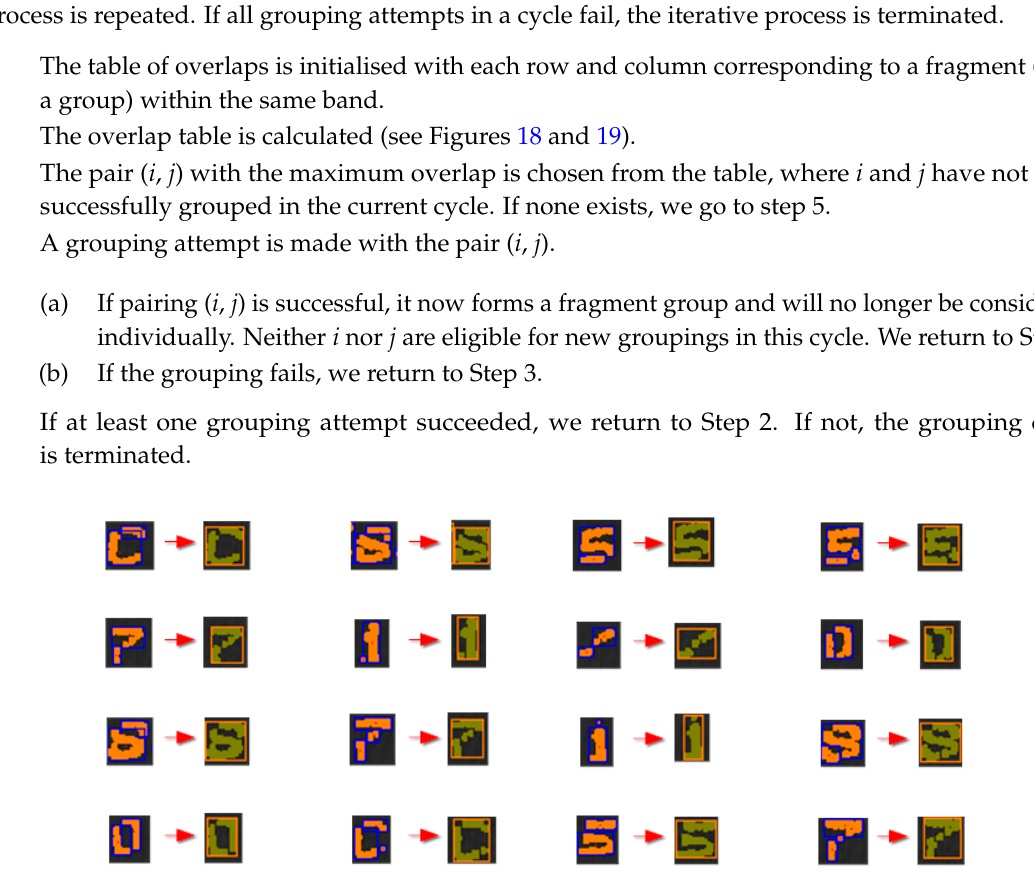
Figure 17. Grouping examples from the MONICOD experiments.